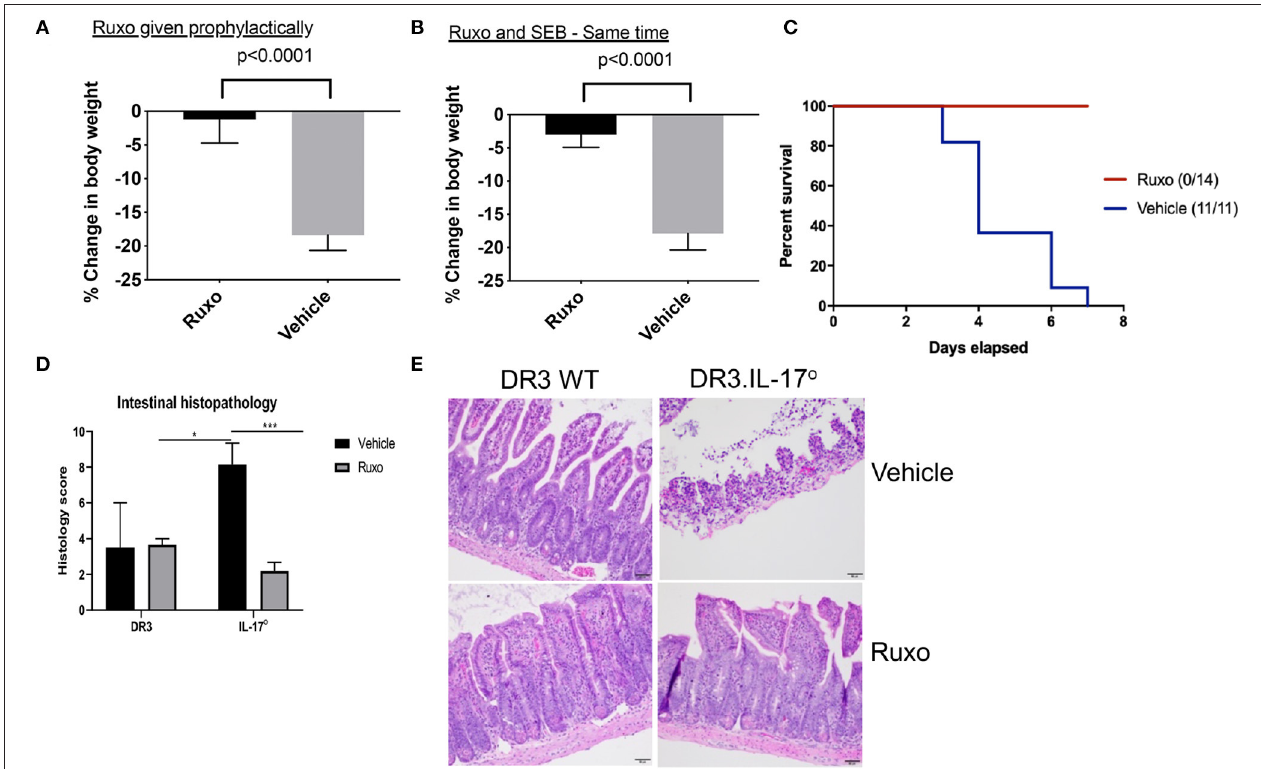
FIGURE 11 | Ruxolitinib protects from superantigen-induced morbidity and mortality. HLA-DR3 transgenic mice were challenged intraperitoneally with 50 µ g of SEB (reference time point 0h). Mice were gavaged with ruxolitinib or vehicle twice daily from 1 day prior to SEB challenge (A) or starting immediately after SEB challenge (B) . Mice were closely monitored, and body weights were determined. Bars represent mean ± SE from 6 to 8 mice from each group. (C) HLA-DR3.IL-17 KO mice were challenged intraperitoneally with 50 µ g of SEB (reference time point 0h). Mice were gavaged with ruxolitinib or vehicle twice daily from 1 day prior to SEB challenge. Mice were closely monitored, moribund animals, and animals that lost more than 20% of their body weight were removed from the study and euthanized as per guidelines. (D,E) Small intestines from mice challenged with SEB and treated prophylactically with ruxolitinib were collected at necropsy (48h), fixed in formalin, and processed routinely for H&E staining. All slides were graded by a board-certified veterinary pathologist. Sections of intestine were scored individually for amount of inflammation, loss of mucosal architecture, and epithelial damage. Scores were then summed to get a composite histologic score for that organ and animal. (E) shows representative images of H&E stained slides of certain fields taken at 20x magnification. DR3 Vehicle, n = 2; DR3 Ruxo, n = 3; IL-17 ◦ Vehicle, n = 7; IL-17 ◦ Ruxo, n = 10. * p < 0.05, *** p <